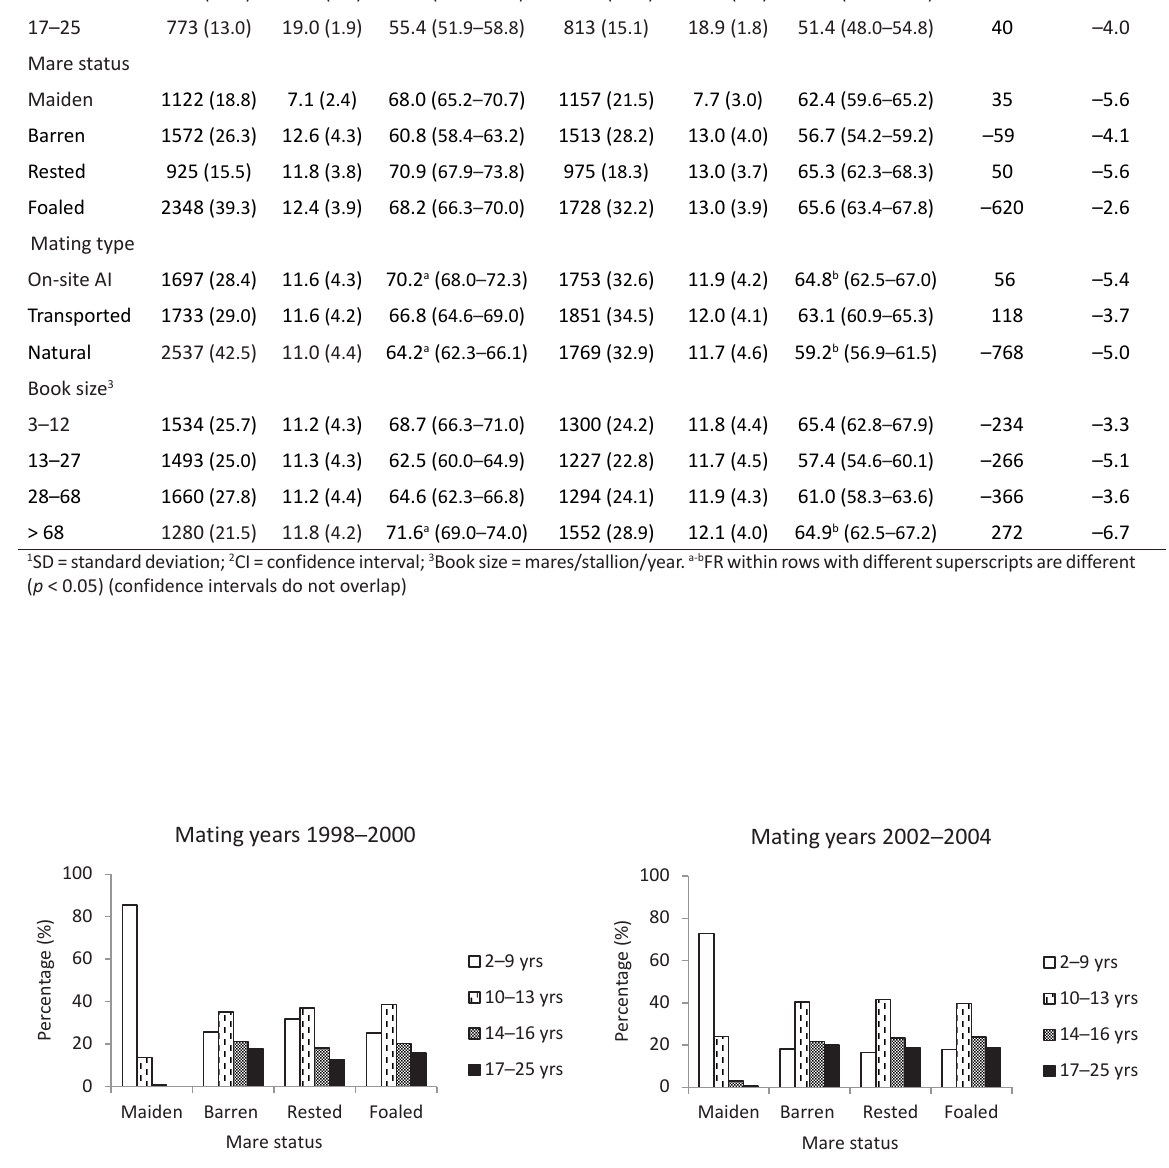
Fig. 2. Age distribution within different mare status groups during mating years 1998–2000 (period 1) and 2002–2004 (period